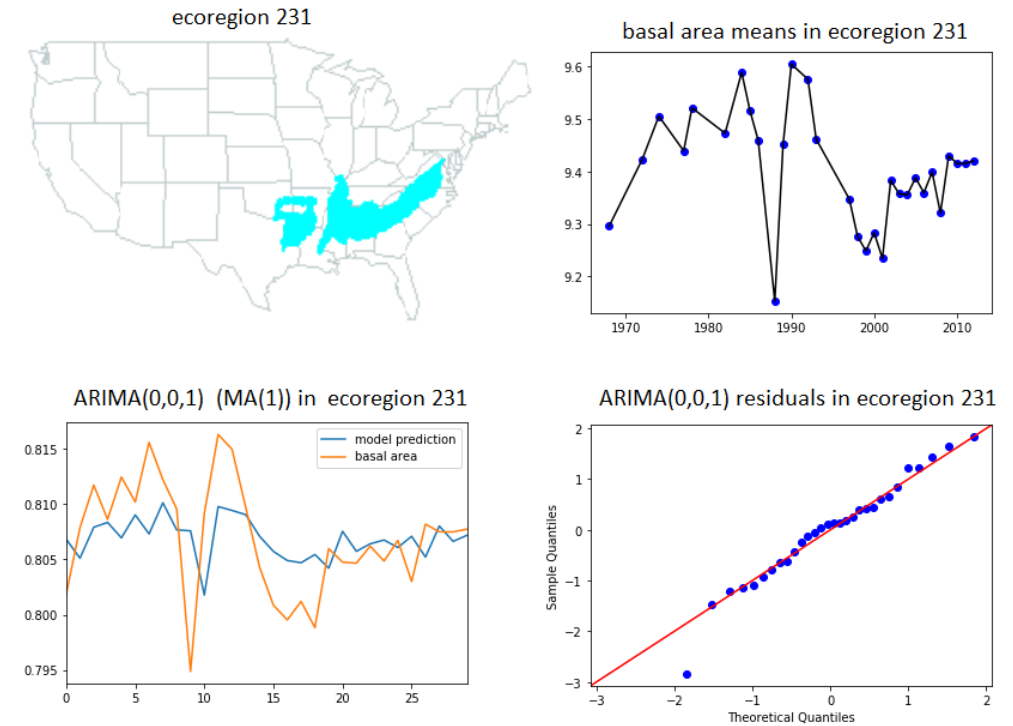
Figure A1. ARIMA (0,0,1) (MA(1)) model results for basal area annual means in ecoregion 231 (Southeastern Mixed Forest Province).